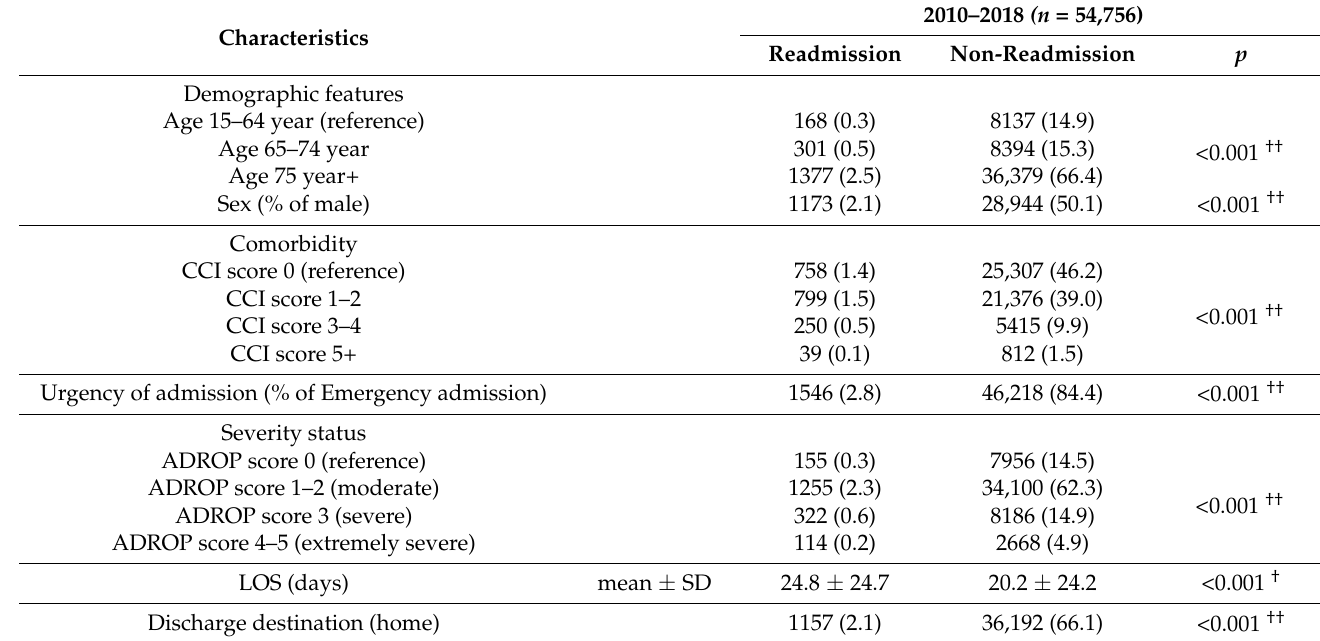
Table 1. Patient demographic characteristics in the analysis using the 9-year data *.